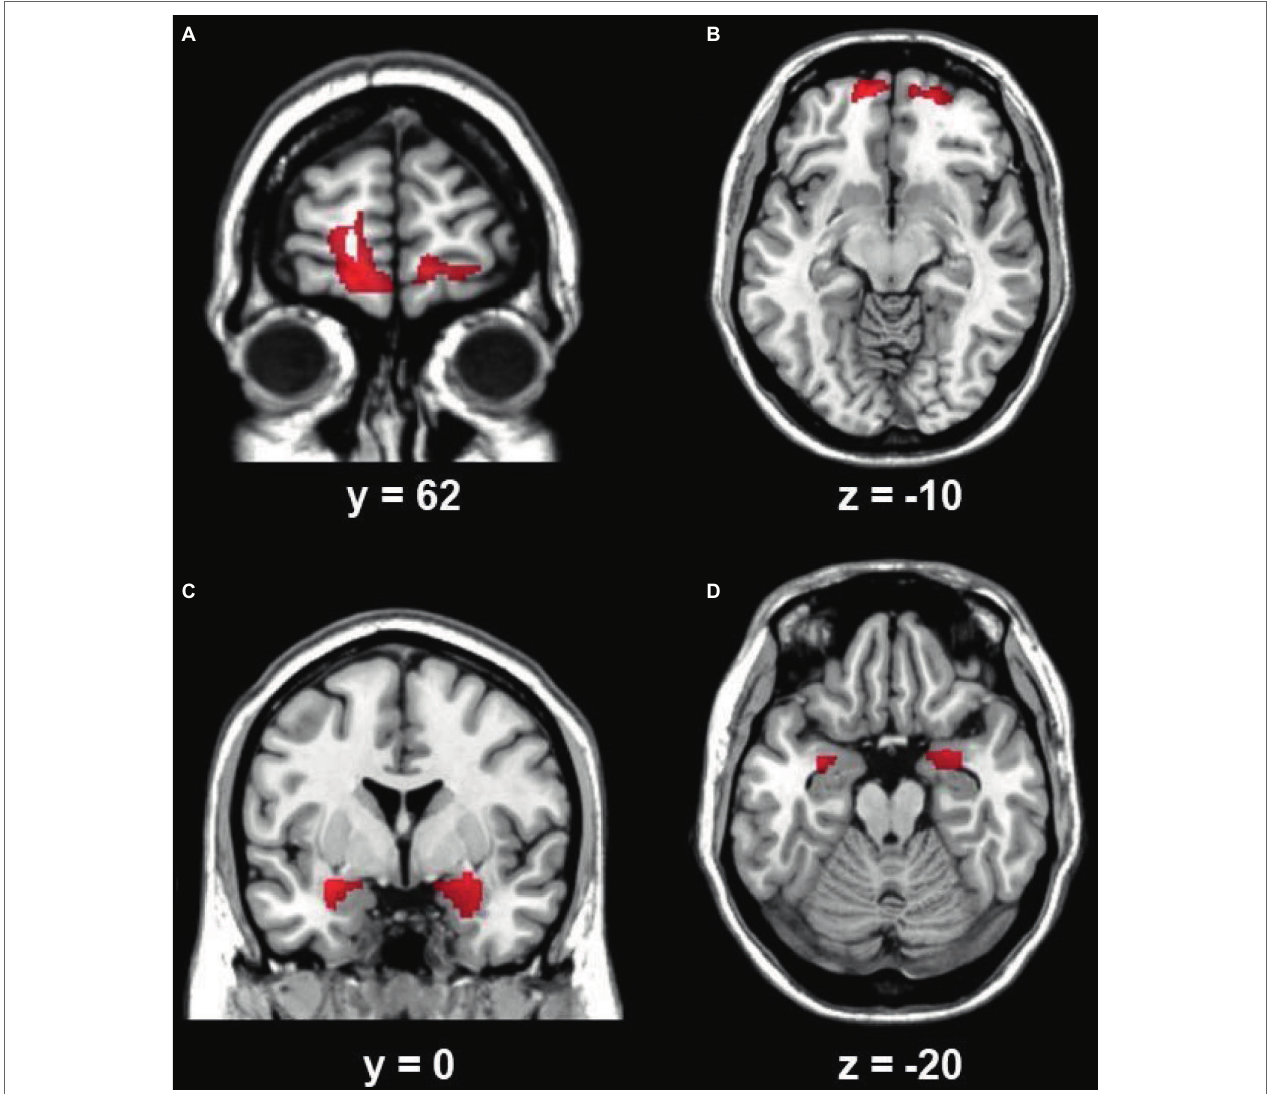
FIGURE 1 | The left (A) and right (B) VMPFC showed lower gray matter volume in BMS patients than in controls. The left (C) and right (D) amygdala showed increased functional connectivity in BMS patients than in controls. The results were mapped onto the standard brain for visual display, with the left side representing the right